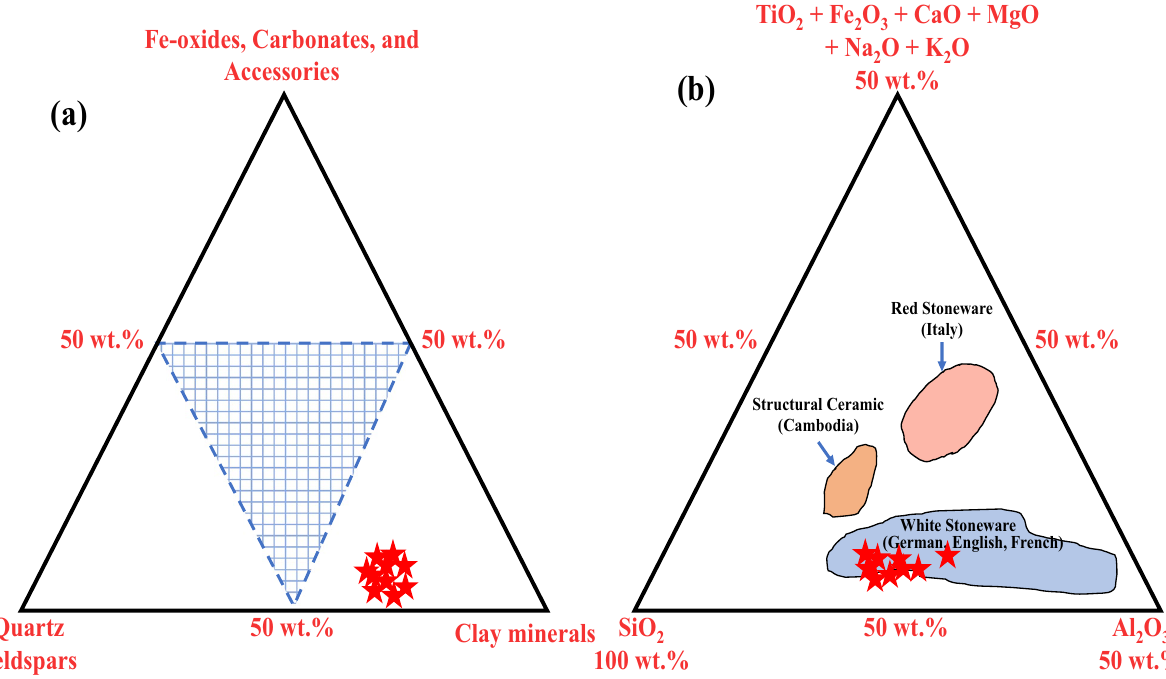
Figure 7. Illustrates: ( a ) Ternary diagram of Fiori et al. (1989) 75 for classification of the ceramic-based clay bodies based on the mineralogical parameters and ( b ) Triangular diagram of clay-rich materials of Fabbri and Fiori (1985) 76 based on the geochemistry